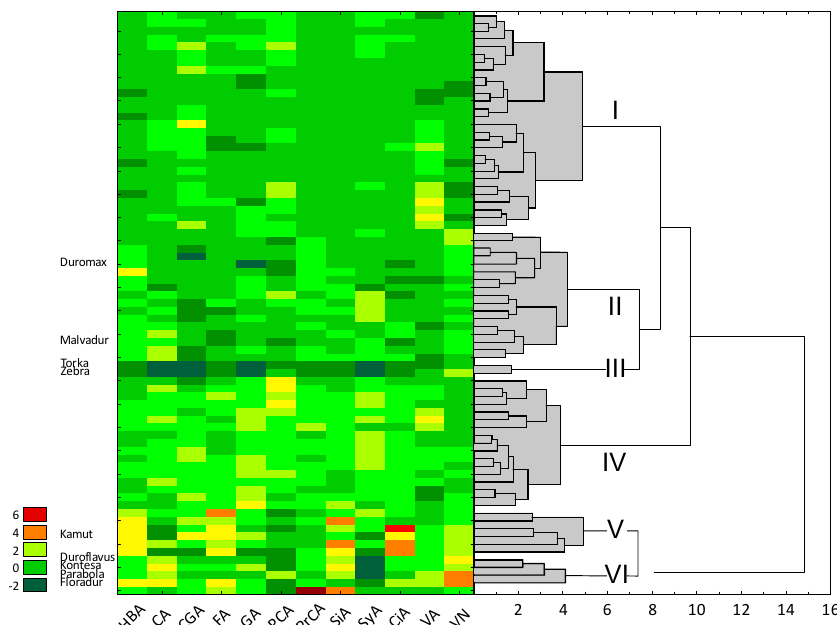
Figure 4. The results of cluster analysis for the concentrations of 11 phenolic acids and vanillin in the grain of the analyzed T. polonicum accessions versus four durum wheat cultivars (Floradur, Duroflavus, Malvadur, and Duromax), four bread wheat cultivars (Kontesa, Parabola, Torka, and Zebra) and